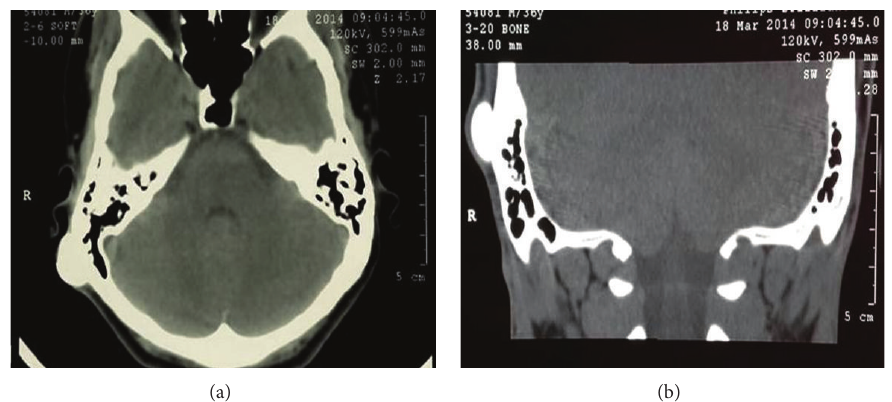
Figure 2: (a) Osteoma in axial cut CT scan. (b) Osteoma in coronal cut CT scan.